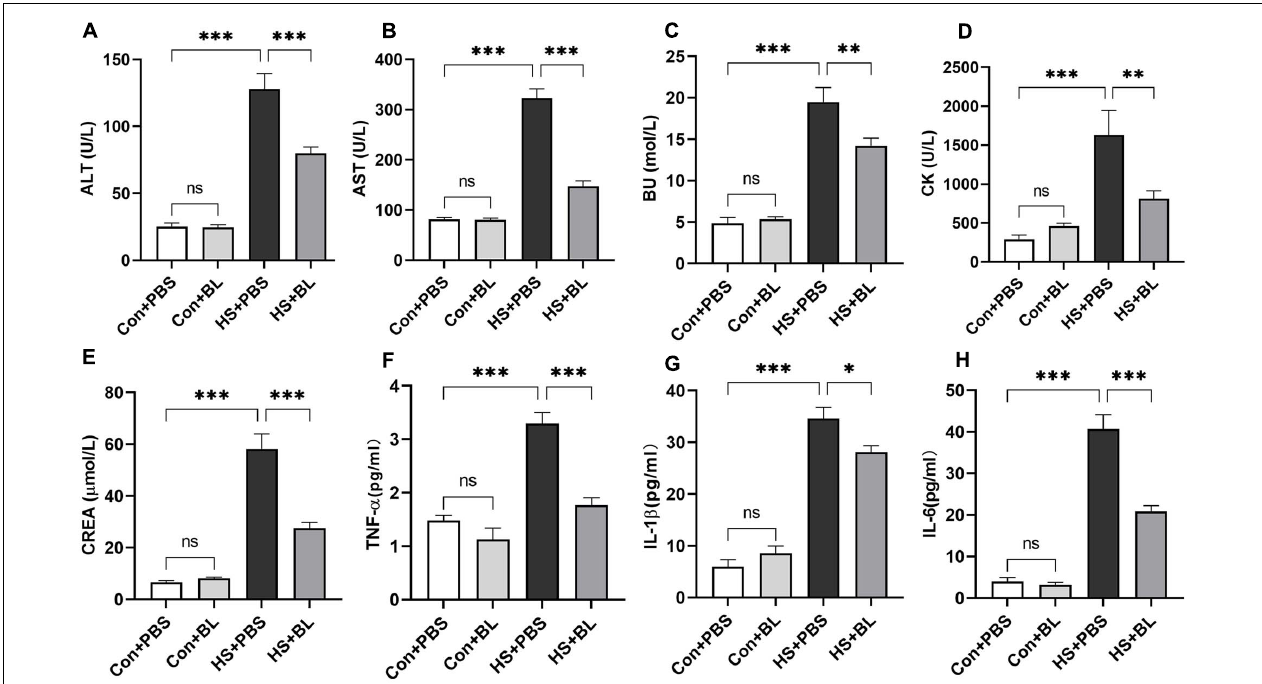
FIGURE 2 | BL pre-administration decreased levels of serum biochemical markers and inflammatory cytokines. Rats were pre-administered with 1 × 10 8 CFU twice a day (HS + BL group) for 7 days or PBS (HS + PBS group), and blood samples were collected 3 h after HS onset and at the same time for the control group rats. Serum biochemical marker levels of ALT (A) , AST (B) , BU (C) , CK (D) , and CREA (E) and inflammatory cytokines TNF- α (F) , IL-1 β (G) , and IL-6 (H) are presented as means ± SEM, n = 10 per group. ns P > 0.05, ∗ P < 0.05, ∗∗ P < 0.01, ∗∗∗ P < 0.001. ALT, alanine aminotransferase; AST, aspartate aminotransferase; BU, blood urea; CK, creatine kinase; CREA,